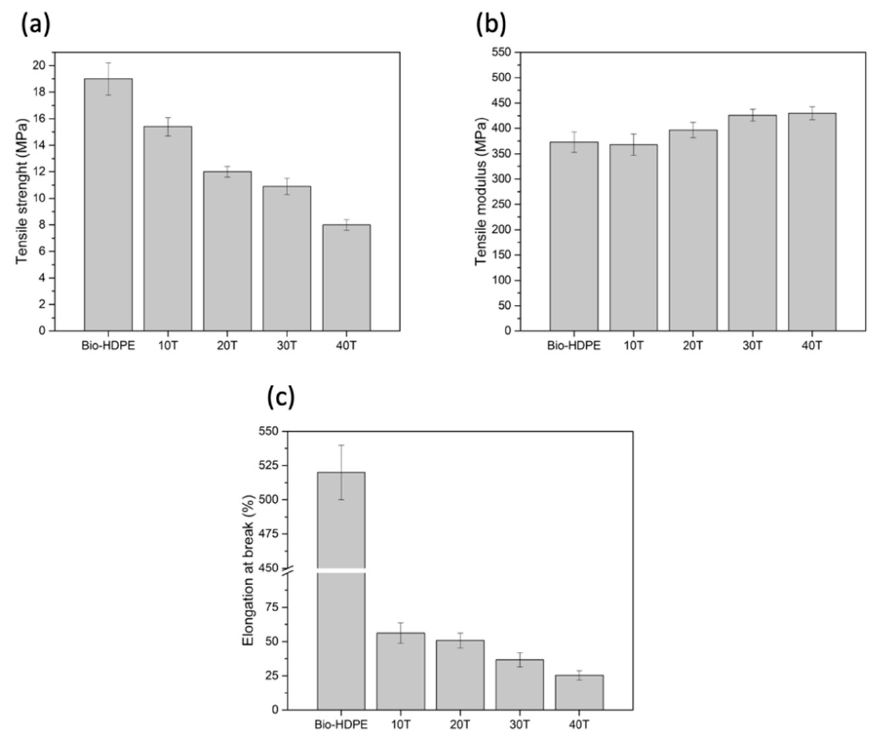
Figure 6. Effect of weight percentage of treated chia seed flour with APS on tensile properties in bio-based high-density polyethylene (Bio-HDPE): ( a ) Tensile strength; ( b ) Tensile modulus; ( c ) Elongation at break.